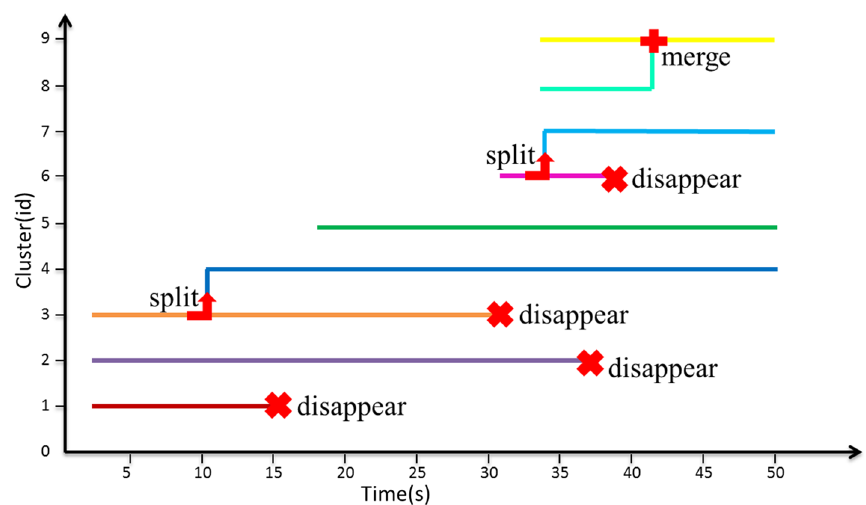
Fig. 13 The evolutionary process of clusters. In the figure 13, the horizontal axis represents the clusters life cycle andthe vertical axis indicates the cluster name. The different line colors indicatethe clusters that exist in the time‑decaying data